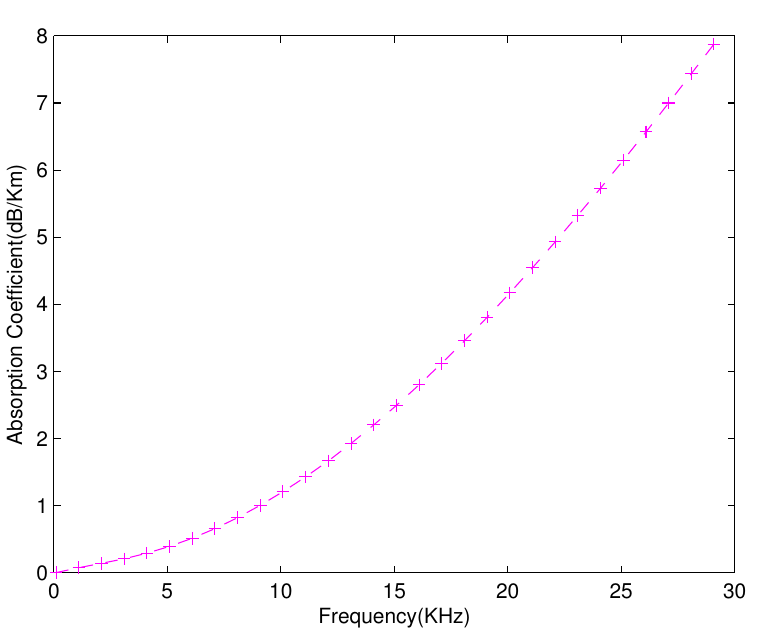
Figure 3. Absorption and Frequency